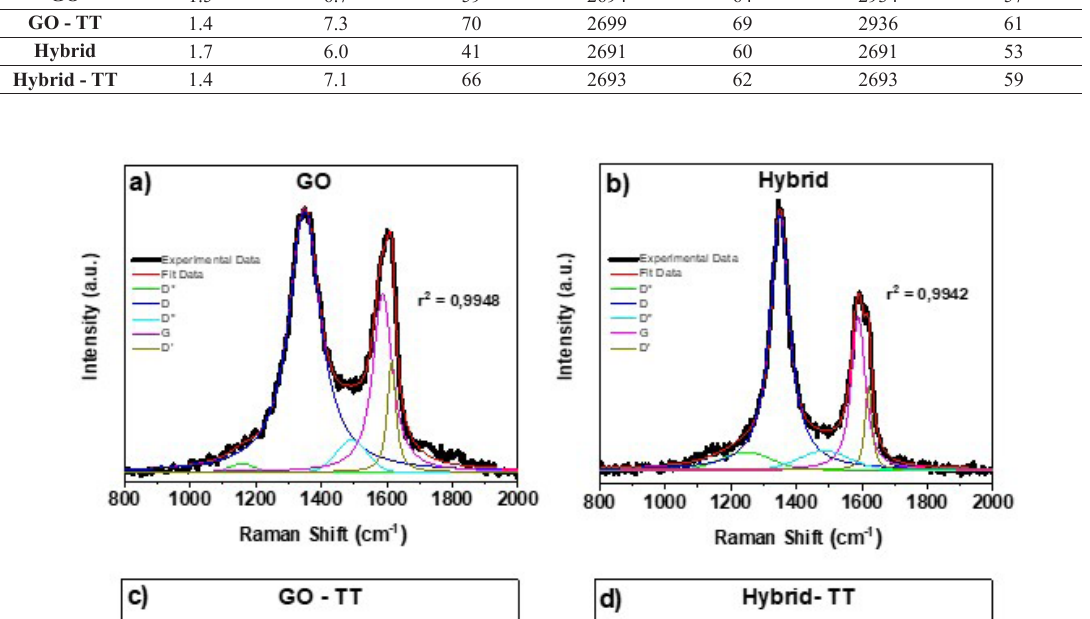
/I value and the maximum positions of the 2D and D + D′ used as parameters for estimating the Csp 2 percentages of paper- Table 3. I D G likes samples untreated and treated according to the protocol available in the literature 40,41 .